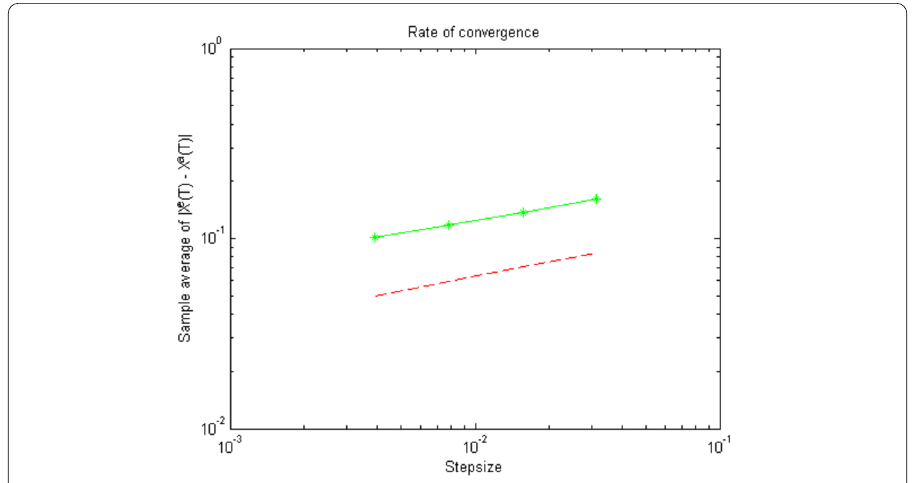
Figure 3 The rate of strong convergence for Example 5.3 with T = 1, c = 0.01. The logarithm of (cid:14) T is denoted by the green line with asterisk which is parallel with the dashed red line by slope 1